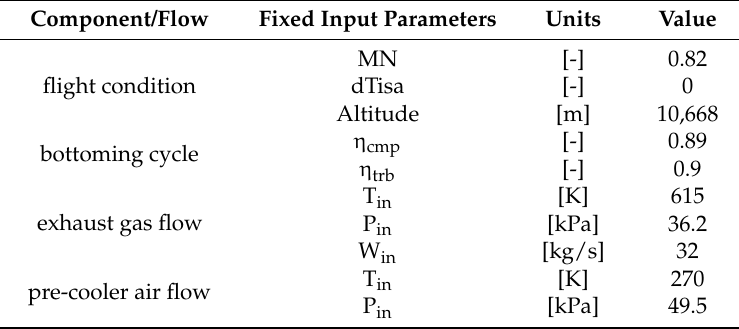
Table A1. Bottoming Cycle main boundary